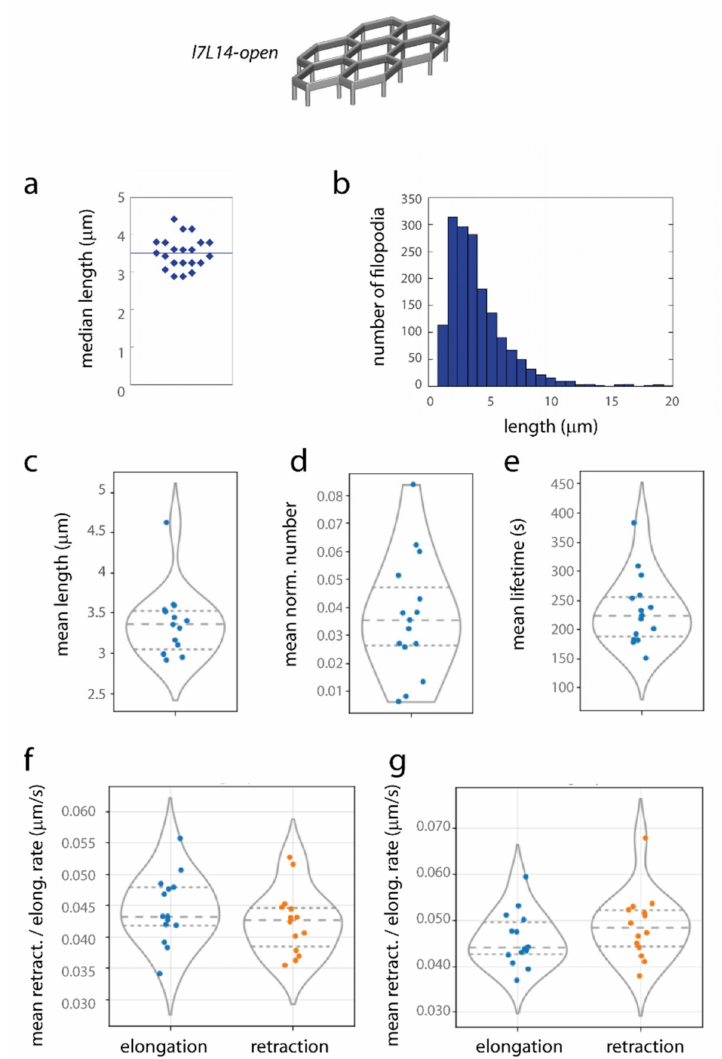
Figure 6. Quantification of filopodia organization. HUVECs were cultivated on l7L14 microstructures, and filopodia quantified. ( a ) Median filopodia lengths from analyses on fixed samples, one point corresponds to one structure (bar: average value). ( b ) Histogram of filopodia lengths from analyses on fixed samples. ( c – g ) Mean values from analyses on timelapse images. Each point of the plot corresponds to the mean filopodia values on one movie ( n = 15 independent movies were analysed, with a typical number of 10–100 filopodia detected at a given time point for each movie). Violin plots are shown, with dotted lines representing quartiles (middle line: median). ( c ) filopodia length, ( d ) number of filopodia normalized by the perimeter (in µ m) of the cell islets inside the structure, ( e ) filopodia lifetime, ( f , g ) elongation (blue) and retraction (orange) rates of the ( − ) ( f ) and (+) ( g ) filopodia